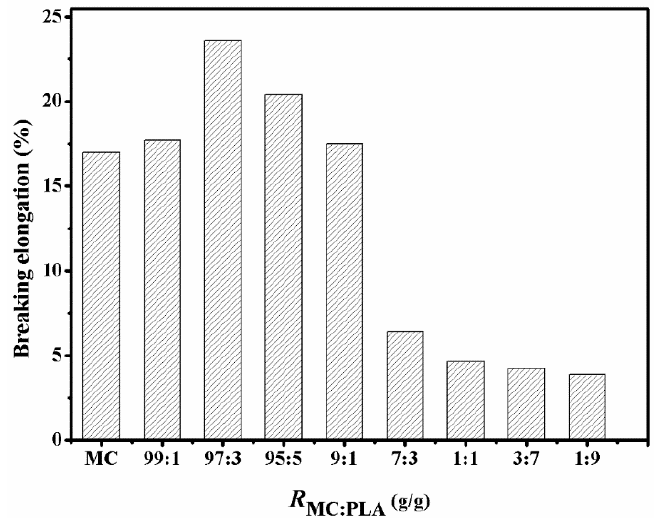
Figure 8. Breaking elongation of MC and MC/PLA membranes as a function of MC/PLA mass ratio ( R MC:PLA ).